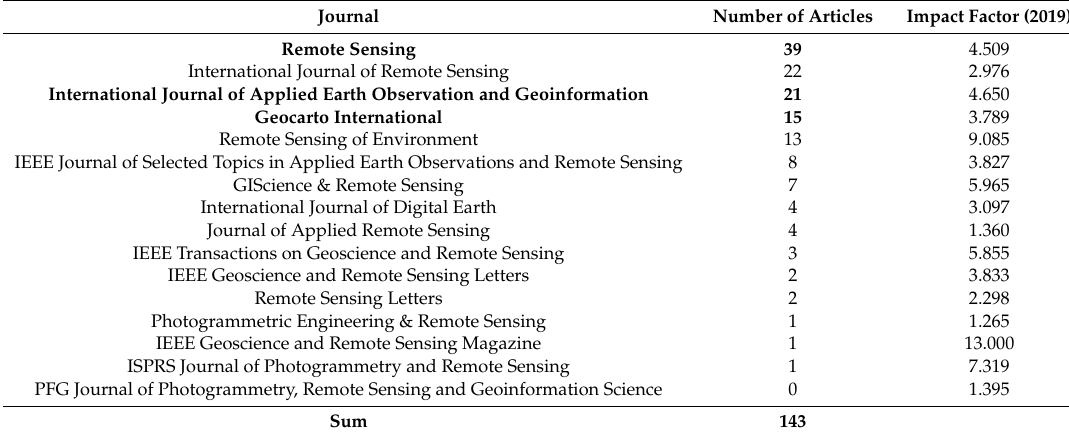
Table 1. List of SCI journals included in the literature review and counts of relevant publications between 2010 and 2020. Numbers in bold contain review articles. Impact Factor according to Web of Science